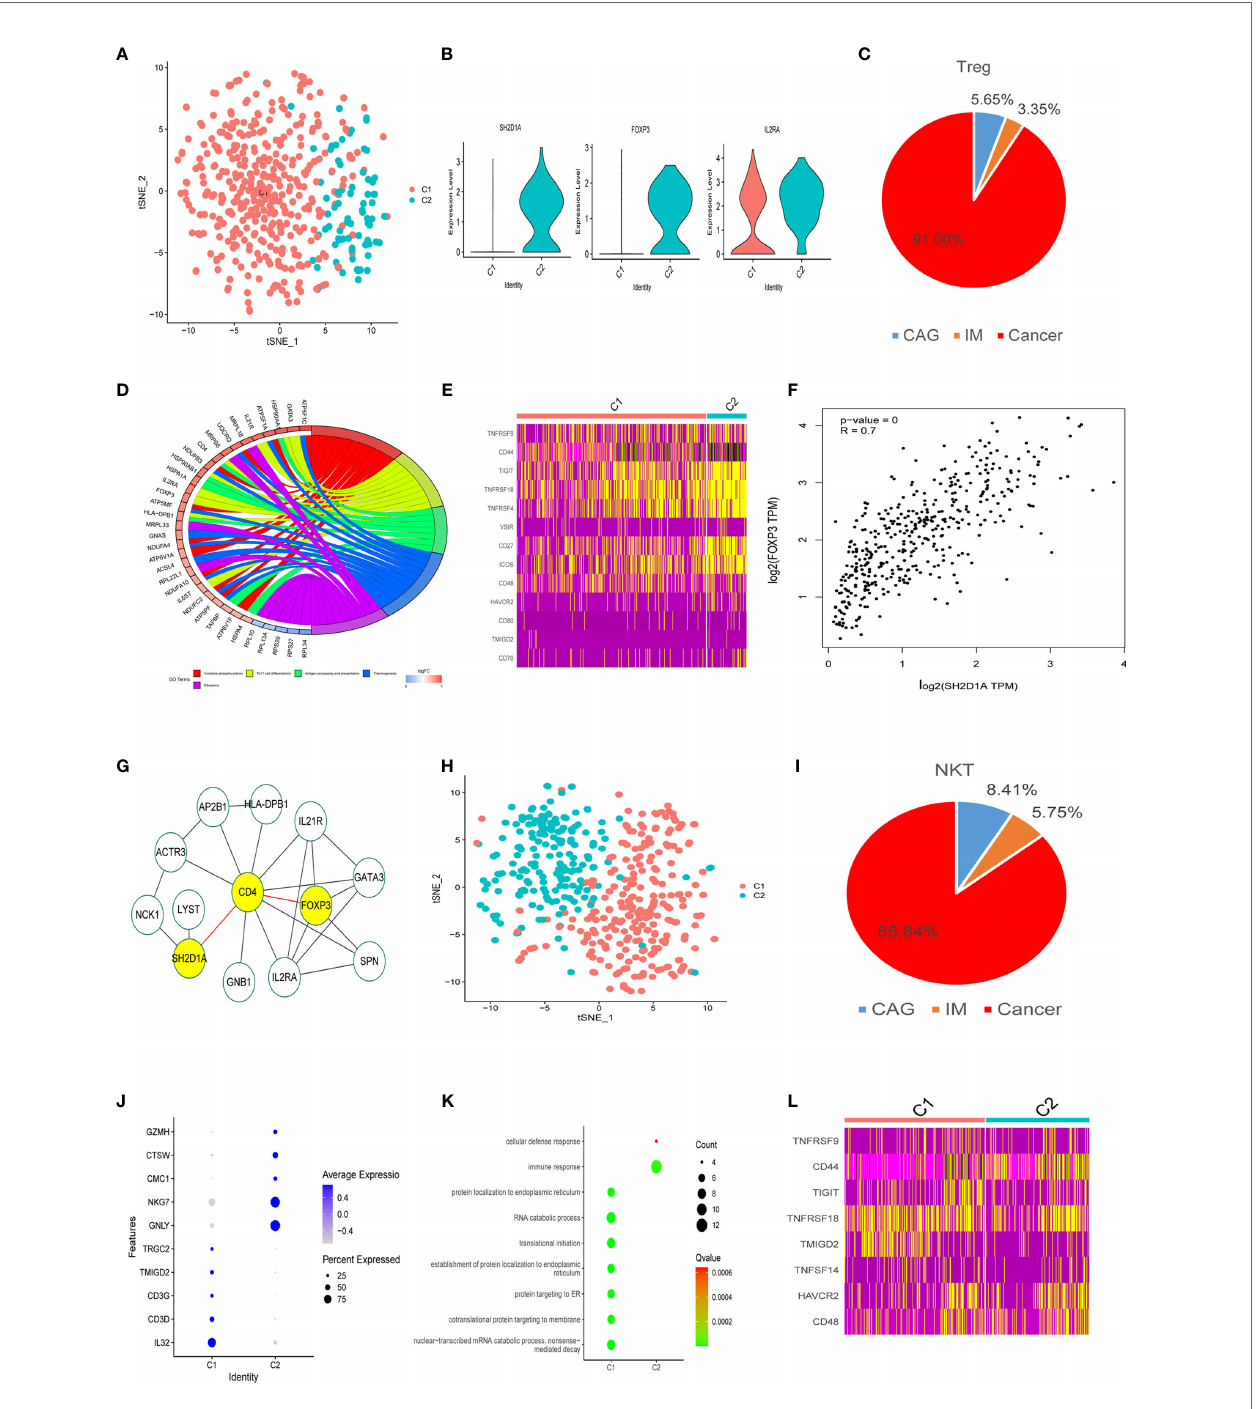
FIGURE 4 | Treg and NKT cell clusters. (A) tSNE plot of two Treg cell subclusters. (B) Violin plots of marker genes for the C2 cluster. (C) A pie chart representing Treg cells from different pathological stages. (D) Circle diagram showing the functions of different cell clusters using GO, colors represent different functions, brighter colors indicate high expression. (E) Heatmap of immune checkpoints altered during the differentiation process of Treg cells. (F) GEPIA was used to assess the correlation of two genes based on the TCGA database. (G) STRING database was used to analyze protein interaction networks, while Cytoscape was used to visualize these networks. (H) tSNE plot of two NK cell subclusters. (I) Pie chart representing NK cells from different pathological stages. (J) Bubble plot of the top fi ve markers in NK cell clusters; dot sizes represent abundance while colors represent expression levels. (K) Bubble plot showing the biological functions of different cell clusters using GO; dot sizes represent abundance while colors represent q values. (L) Heatmap of immune checkpoints altered during NK cell differentiation